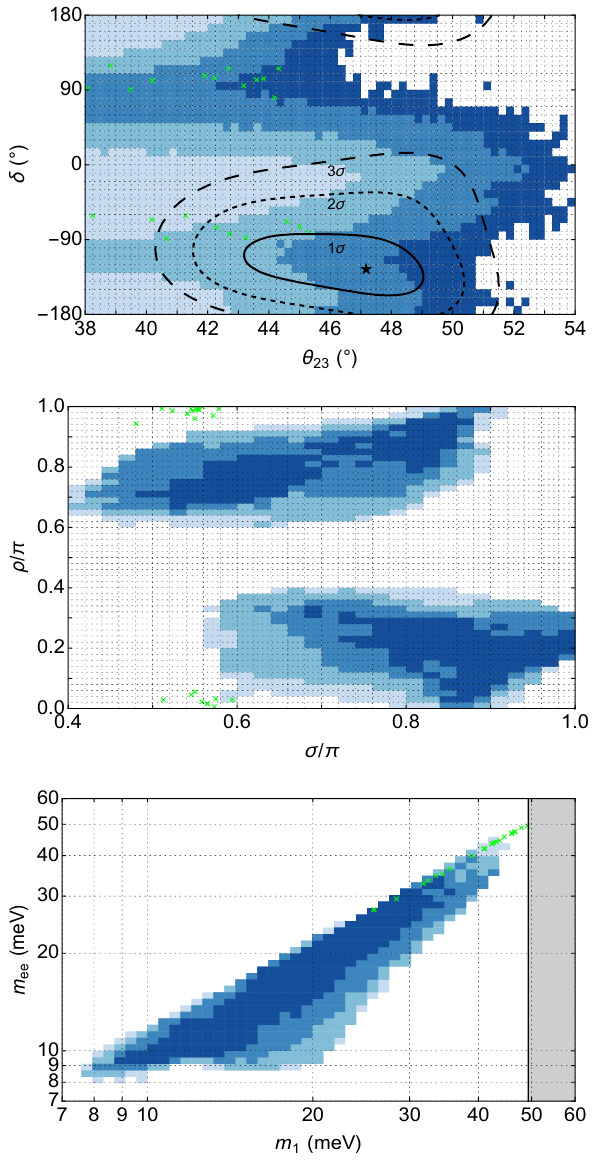
Figure 4 . Allowed region for (cid:11) 2 = 6 and N p ; i